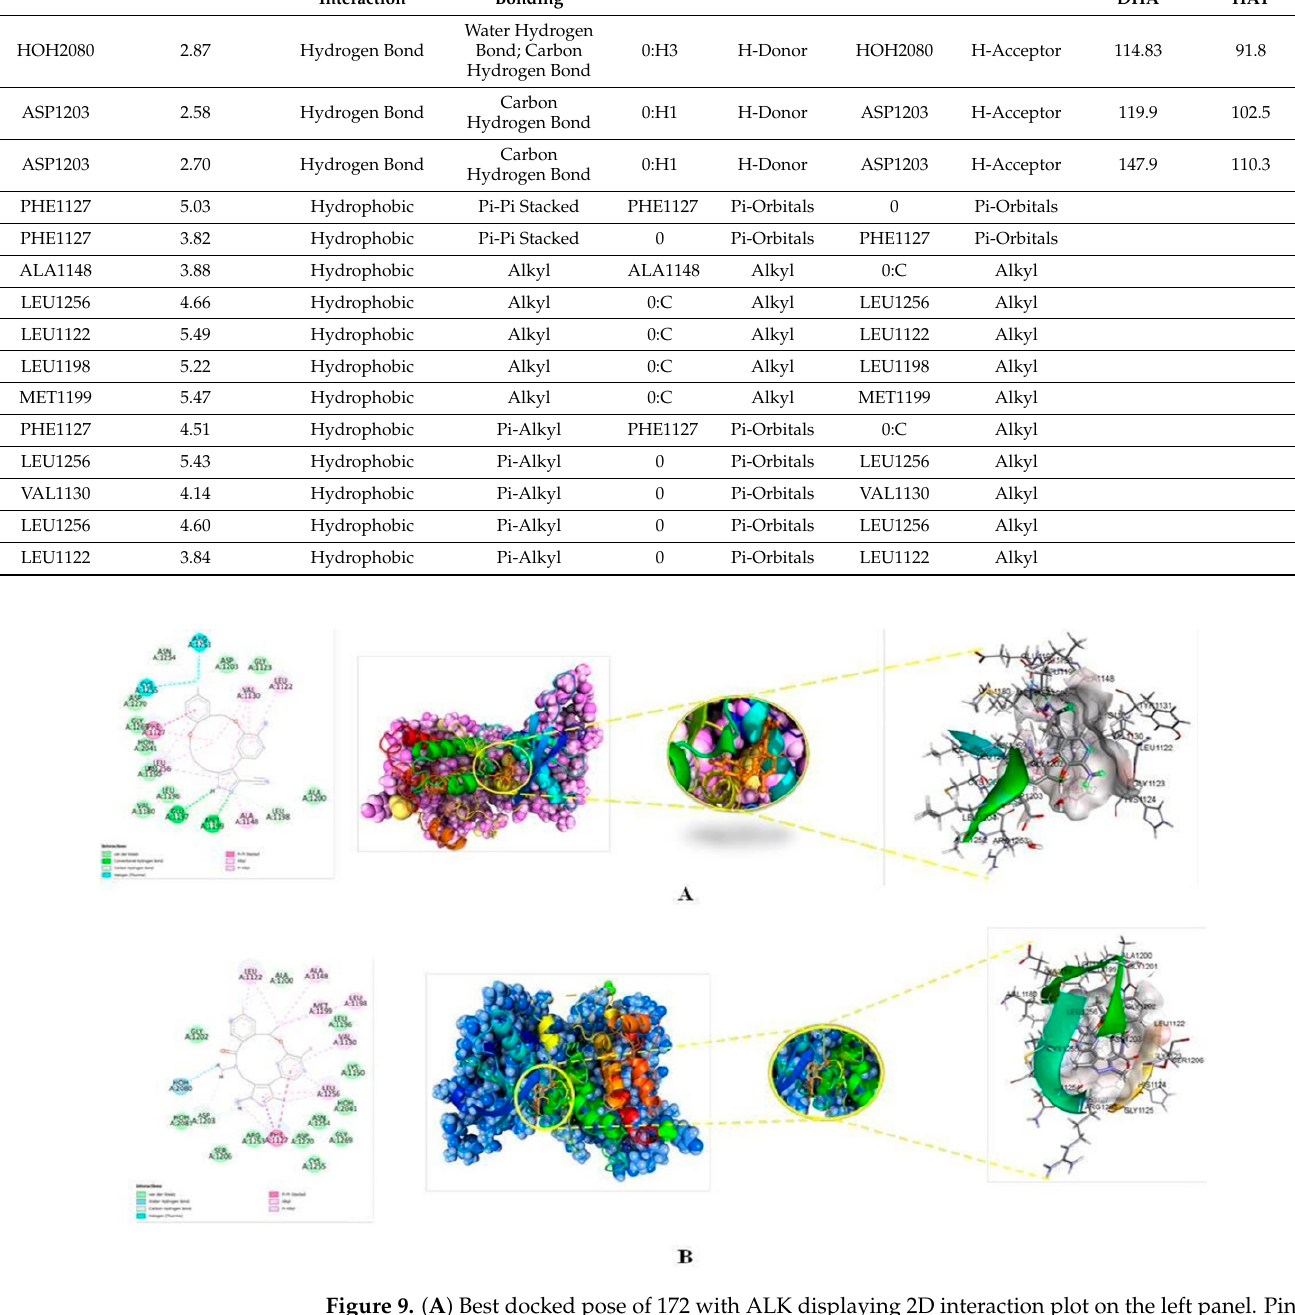
Figure 9. ( A ) Best docked pose of 172 with ALK displaying 2D interaction plot on the left panel. Pink dashed lines indicating the Pi-Alkyl bond and residues embedded in light green sphere indicating to involve in Van der Waals interactions. On the center panel, surface view of ALK displaying binding cavity of 172 and right panel displaying the zoomed out binding pocket having amino acid residues surrounding the 172 molecule; ( B ) Best docked pose of 178 with ALK displaying 2D interaction plot on the left panel. Pink dashed lines indicating the Pi-Alkyl bond and residues embedded in light green sphere indicate involvement in Van der Waals interactions. On the center panel, surface view of ALK displaying binding cavity of 178 and right panel displaying the zoomed out binding pocket having amino acid residues surrounding the 178 molecules.